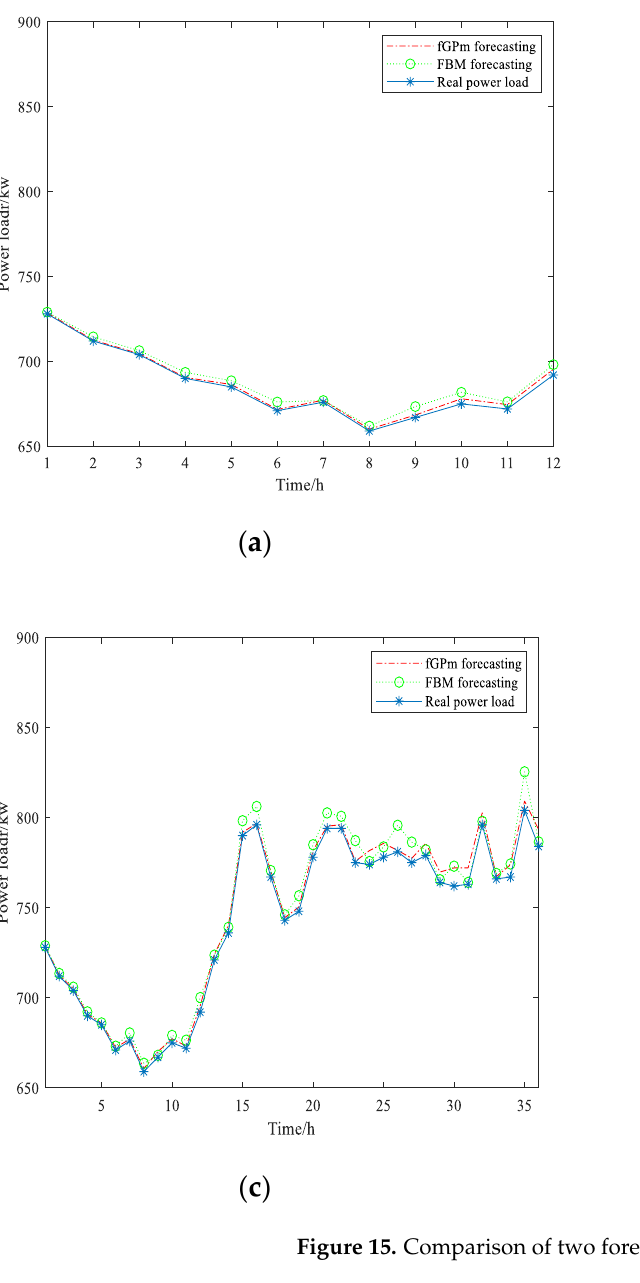
Figure 14. Actual weekend 96 h power load and subsequent forecast 24 h trend chart. ( a ) 6 h ( b ) 12